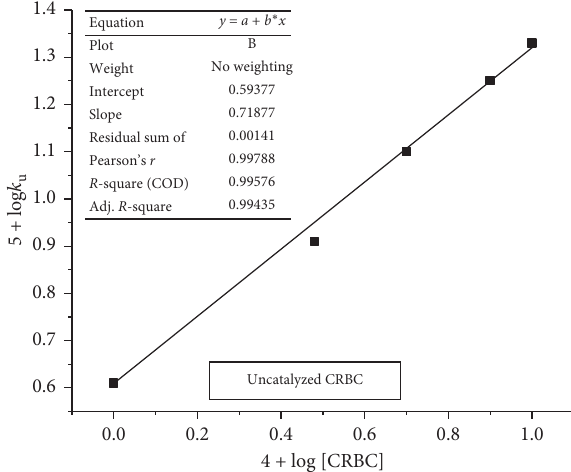
Figure 7: Plot of (5+log k